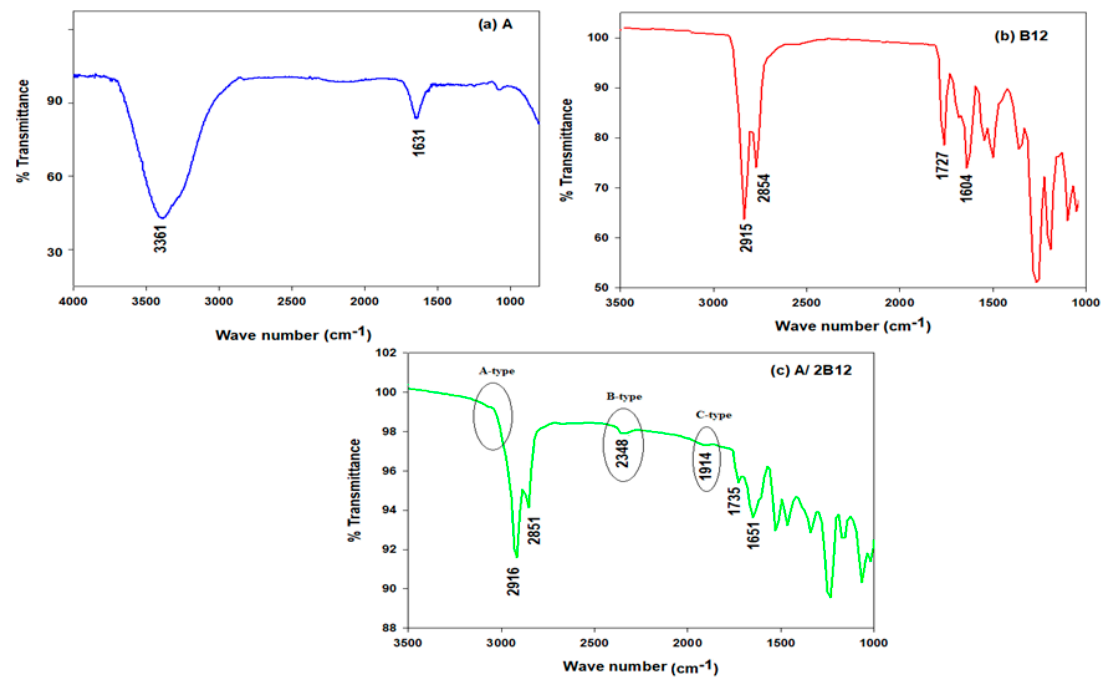
Figure 1. FT-IR spectra of ( a ) acid, A, ( b ) base, B12, and ( c ) complex, A/2B12.